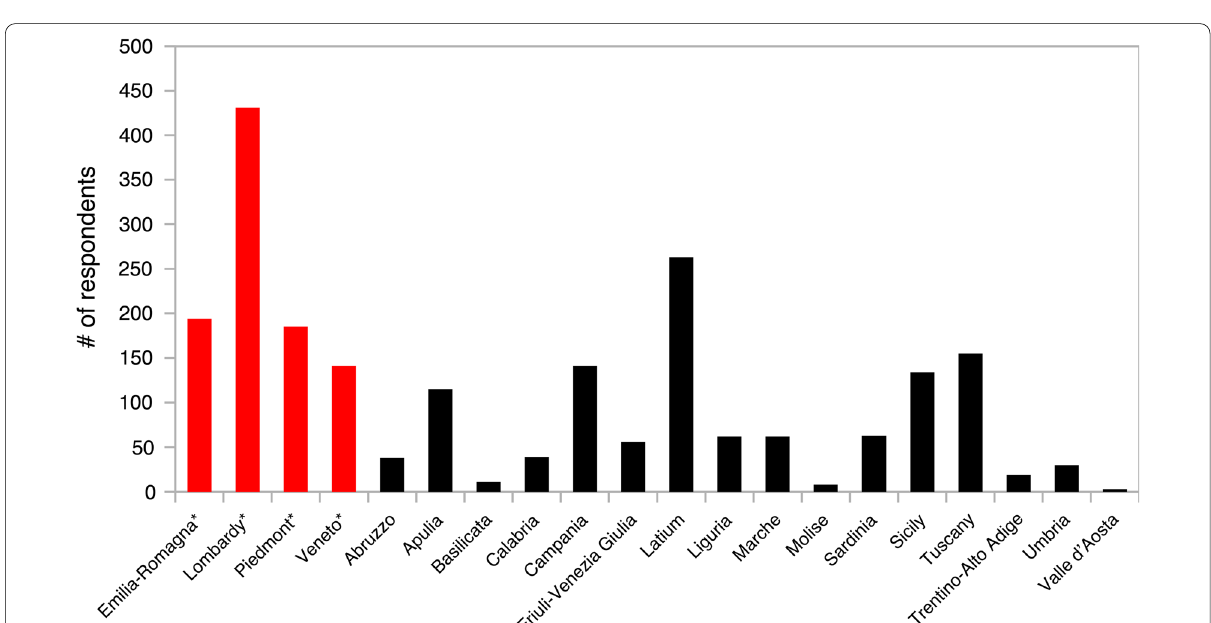
Fig. 1 Bar chart showing the distribution of survey respondents in hot regions (asterisk, left hand side of the chart) and in other regions (right hand